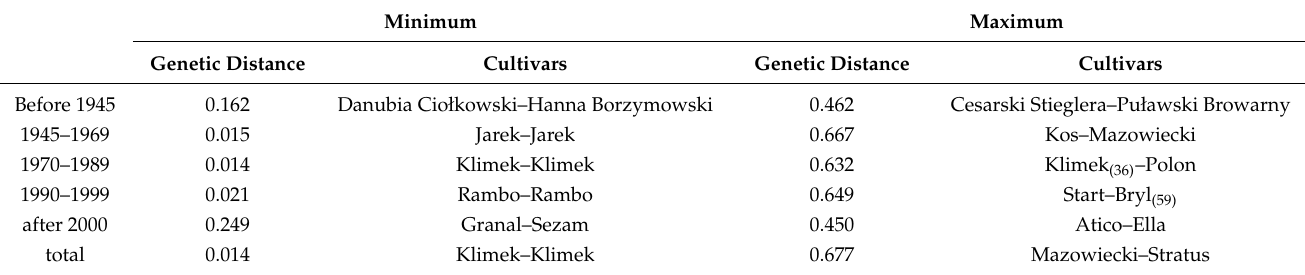
Table 4. Summary of Jaccard genetic distance analysis for 83 spring barley cultivars based on DArTseq-derived